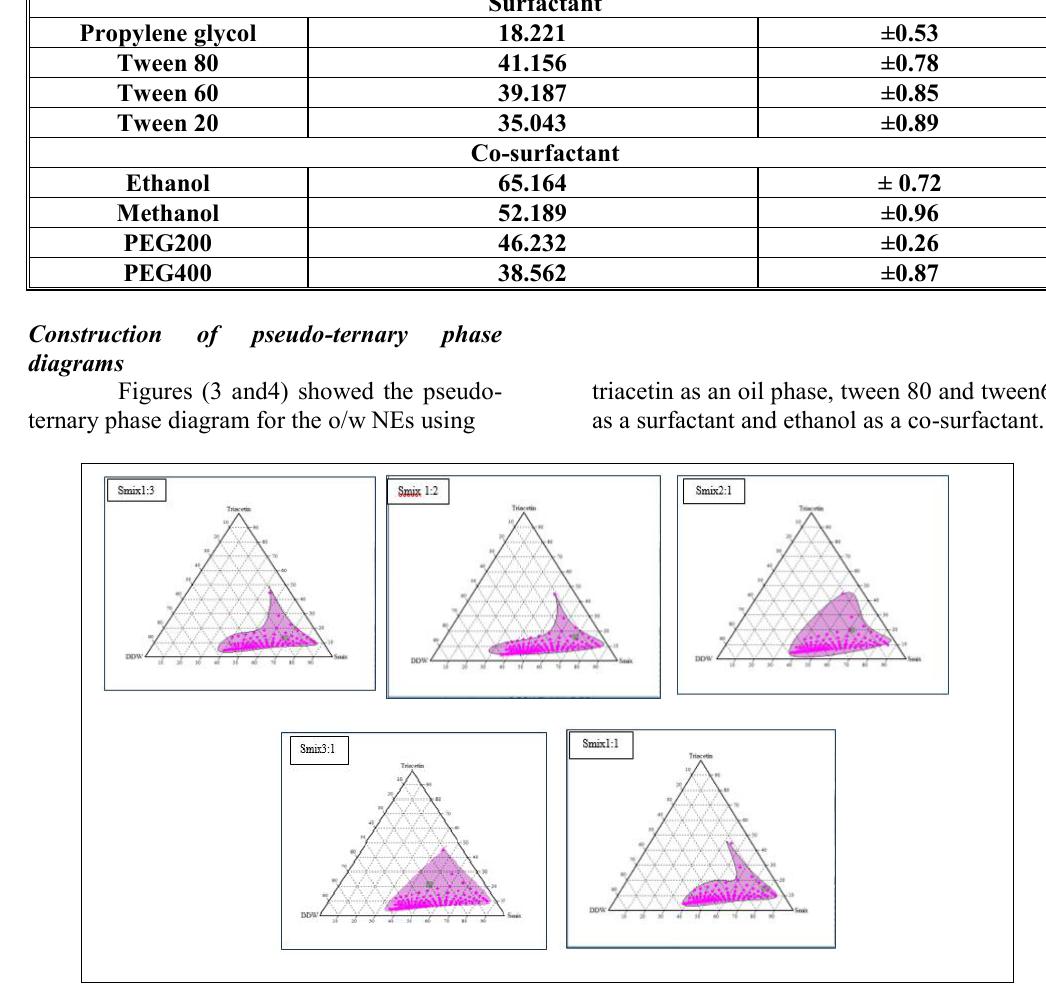
Figure 3.pseudo-ternary phase diagram o/w emulsion diagram using triacetin, tween 80: ethanol in different